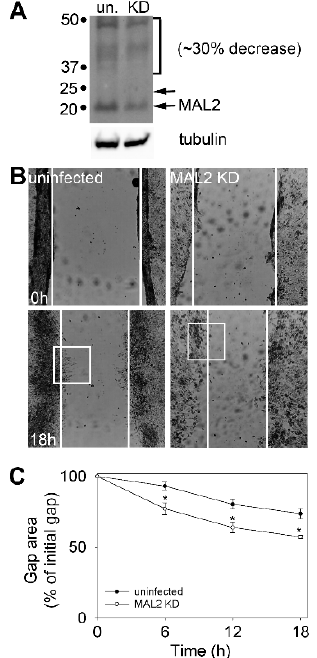
Figure 3. MAL2 knockdown in Hep3B cells enhances cell migration. ( A ) Lysates from uninfected (un) Hep3B cells or cells knocked down (KD) for MAL2 expression with anti-sense MAL2 recombinant adenoviruses for 4 days were immunoblotted for endogenous MAL2 or tubulin. Molecular weight markers are indicated on the left in kDa. A ~30% reduction in MAL2 levels was observed. ( B ) Wound healing was imaged at 0 and 18 h post-scratch. White lines indicate the border of the monolayer along the scratch. Boxed areas were enlarged and shown in Figure 4A. ( C ) The gap area remaining relative to the initial scratch area was determined 0, 6 ( p ≤ 0.013), 12 ( p ≤ 0.014) and 18 h ( p ≤ 0.002) after recovery. The values represent the average ± SEM determined from at least three independent experiments.